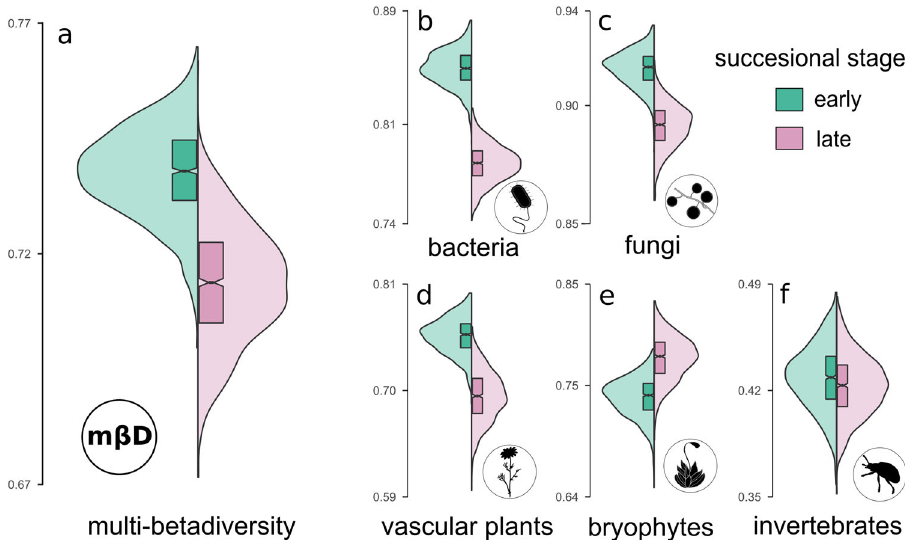
Fig. 4 Betadiversity values for each organismal group and community-wide multi-betadiversity values for the early and late successional stages. Mean Bray-Curtis dissimilarities were used to calculate betadiversity and multi-betadiversity values. Green violin plots resemble the dissimilarity values of the early successional stage ( n = 44 plots), rose violin plots indicate the late successional stage ( n = 66 plots). Boxplots indicate the upper and lower quartile of the estimates, and the size of the notch represents the con fi dence interval of the median. a mean of all organismal groups, i.e., multi-betadiversity ( b ) bacteria, c fungi, d vascular plants, e bryopyhtes, and ( f ) invertebrates. Silhouette images were obtained from PhyloPic (http://phylopic.org) under